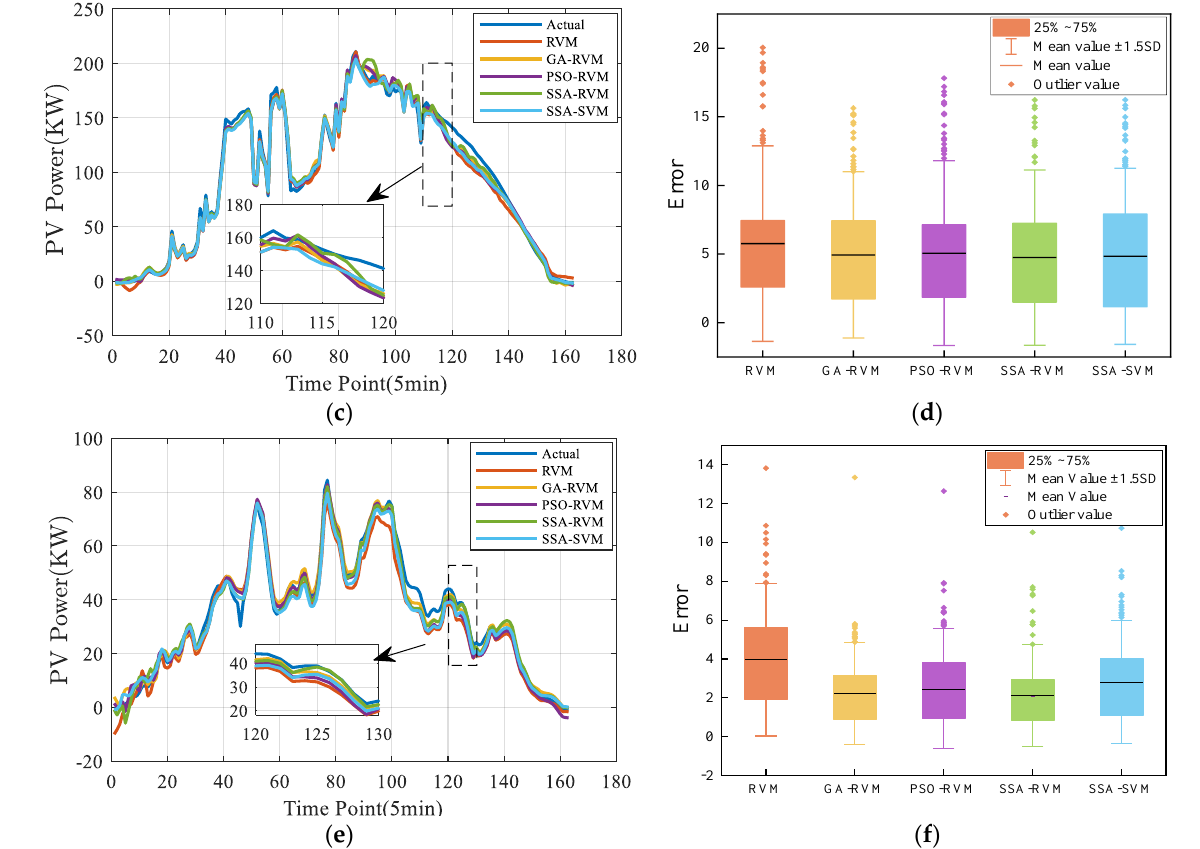
Figure 6. Prediction results of different methods under different weather types in summer: PV power prediction results in ( a ) sunny, ( c ) cloudy and ( e ) rainy, forecasting error in ( b ) sunny, ( d ) cloudy, and ( f ) rainy.